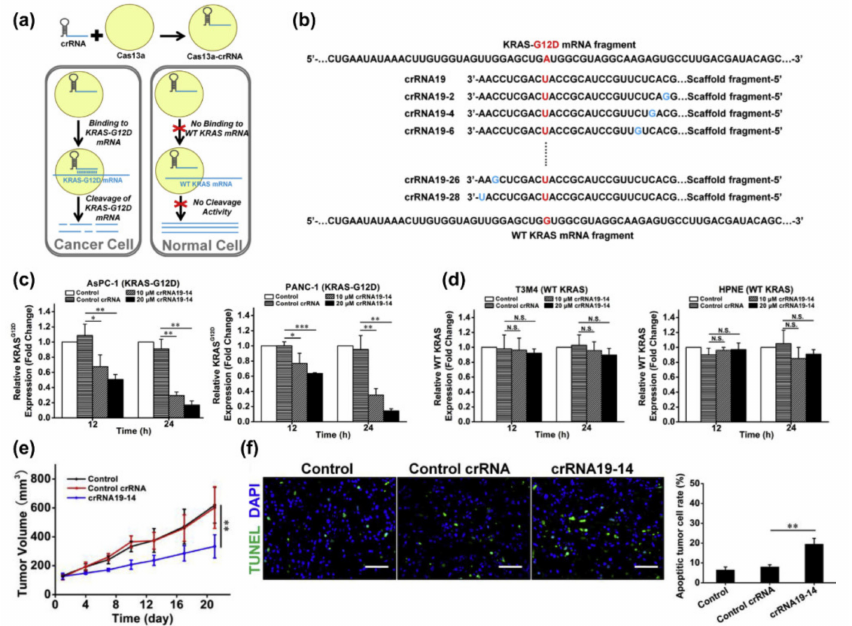
Figure 4. CRISPR/Cas13a-lipofectamine CRISPRMAX delivery for KRAS mutated pancreatic cancer treatment. ( a ) The scheme of Cas13 system differentiates wild type (WT, normal cells) and mutated KRAS genes (cancer cells). ( b ) crRNA sequences of the crRNA19-target sequence in KRAS-G12D and KRAS WT. ( c ) qRT-PCR analysis of KRAS-G12D mRNA expression after crRNA19-14 delivery into KRAS-G12D mutated cells. ( d ) qRT-PCR analysis of KRAS-WT mRNA expression after crRNA19-14 delivery into KRAS-WT cells. ( e ) The tumor volumes of subcutaneous AsPC-1 xenograft after admin- istration with repeated intratumoral injections of the Cas13a-lipofectamine for 21 days. ( f ) Staining for apoptotic cells in tumor tissues (green fluorescence). Scale bar: 50 µ m. (mean ± SD, * p < 0.05, ** p < 0.01, and *** p < 0.001) (adapted from Ref.